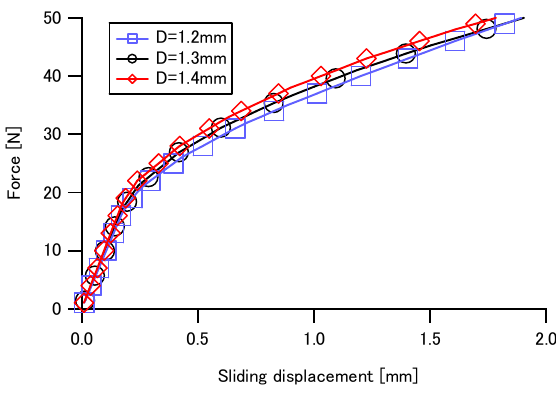
Figure 14. Effect of string diameter on sliding of